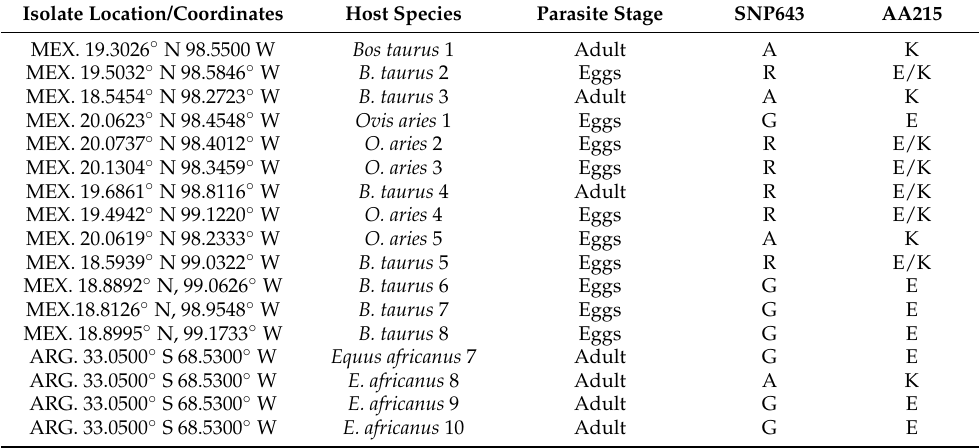
Table 3. Summary of allelic distribution in parasites obtained from different host species and geographical origins. CestB sequences from Mexico (Mex.) and Argentina (Arg.), were obtained from parasites isolated from different host species and the SNP at position 653 as well as the amino acid substitution in position 215 were indicated. Isolates coordinates were included as location